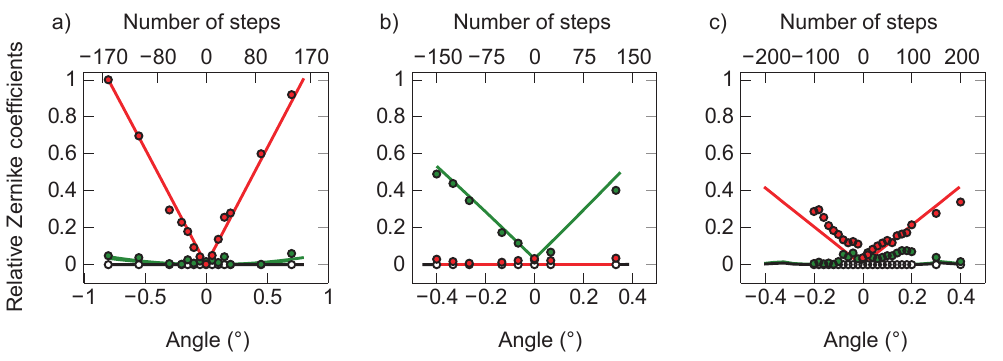
Figure 4. Relative Zernike coefficients for the main aberrations as a function of the angle of the ( a ) rotation stage; ( b ) horizontal goniometer; and ( c ) vertical goniometer. The experimental data are represented as circled colored dots, plotted as a function of the number of steps (top axis). The ray-tracing simulation data is represented as solid lines, plotted as a function of the angle in degrees (bottom axis). Red corresponds to 45° astigmatism, green to 0° astigmatism, and white to the averaged coma.